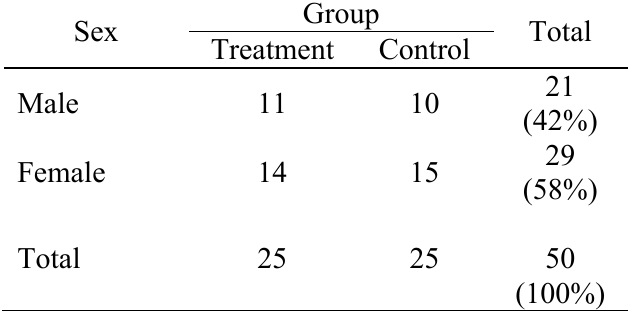
Table 1. Characteristic of samples by gender